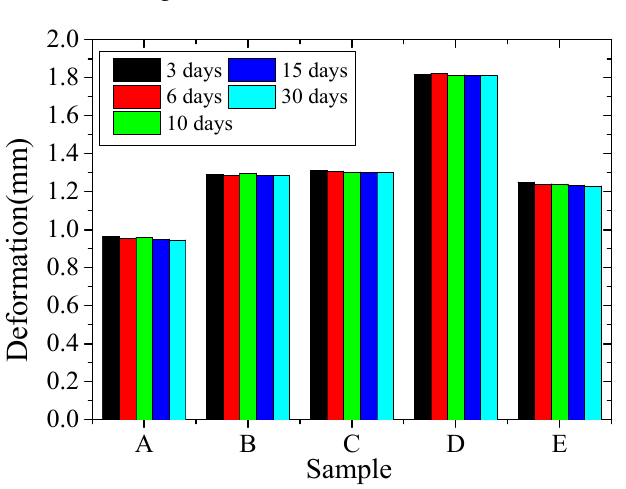
Figure 10. Deformation after VSR.